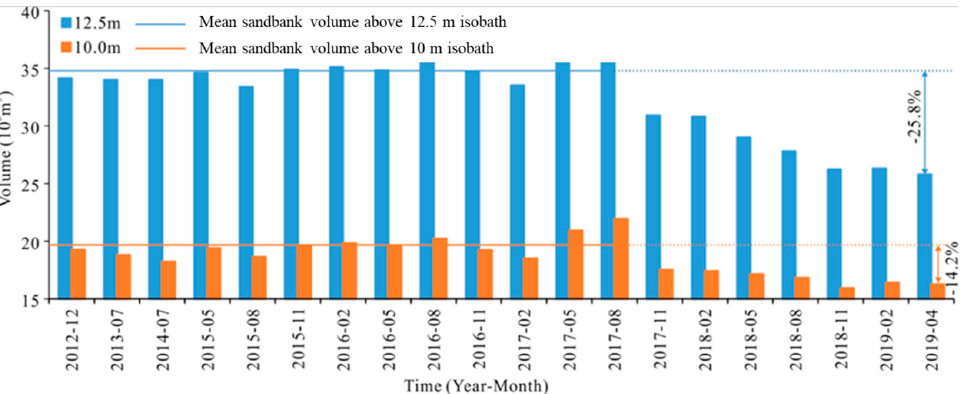
Figure 7. Changes in the volume of the Jingjiang Beach; the line represents the mean value of volume before August 2017. before August